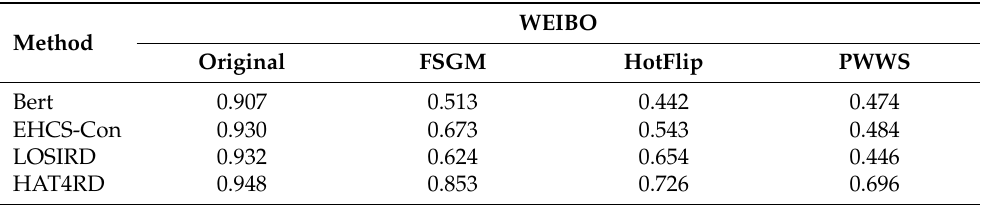
Table 4. The classification accuracy of models on the WEIBO chinese dataset and the perturbed datasets using different attacking